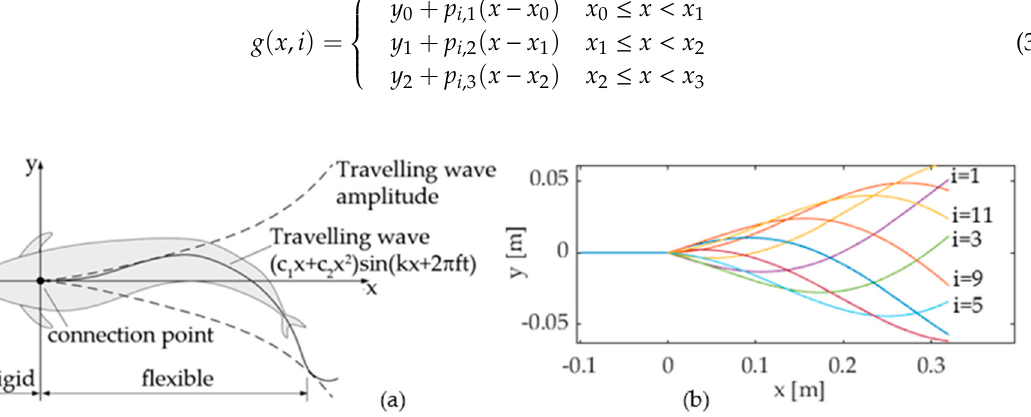
Figure 4. ( a ) Travelling wave pattern [1]. ( b ) Tail posture discretization ( c 1 = 0.2, c 2 = 0; k = 7.5, f = 1, M = 18).